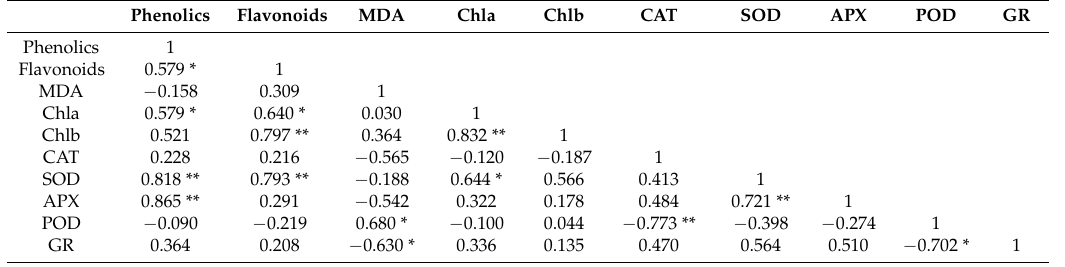
Table 2. Correlation ( R 2 ) among measured parameters relating to phenolics, flavonoids, lipid peroxidation, chlorophylls and antioxidant enzyme activities. Phenolics Flavonoids MDA Chla Chlb CAT SOD